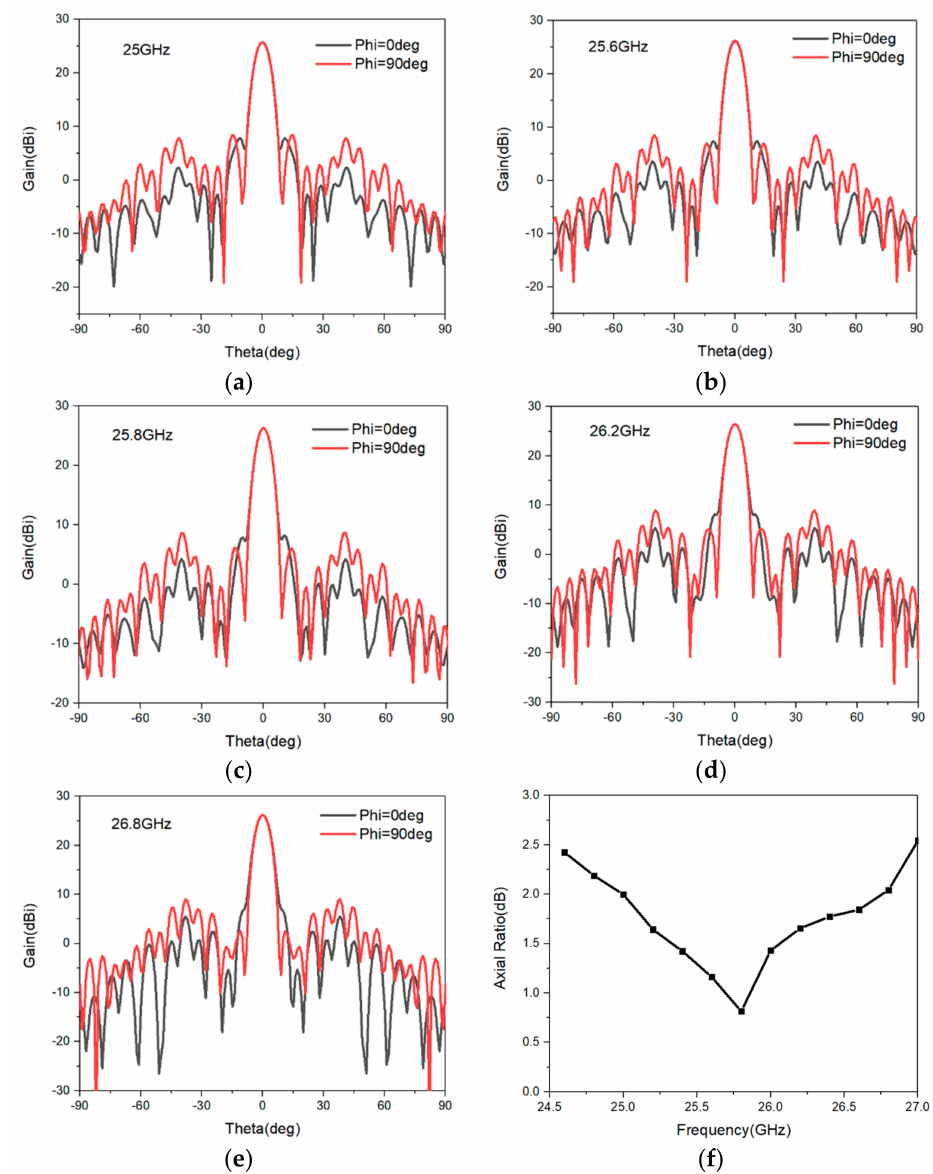
Figure 5. Radiation properties of the transmit-array with the proposed unit-cells over the frequency range 24.5–27 GHz: ( a ) gain pattern at 25 GHz; ( b ) gain pattern at 25.6 GHz; ( c ) gain pattern at 25.8 GHz; ( d ) gain pattern at 26.2 GHz; ( e ) gain pattern at 26.8 GHz; ( f ) axial ratio of transmit array in dB.